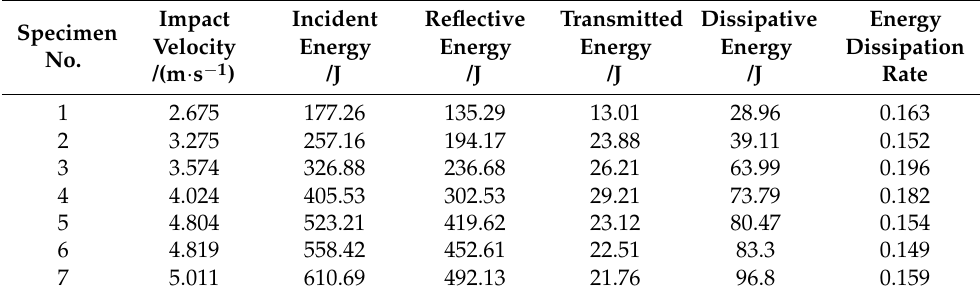
Table 4. Energy calculation results of coal rocks under dynamic impact.